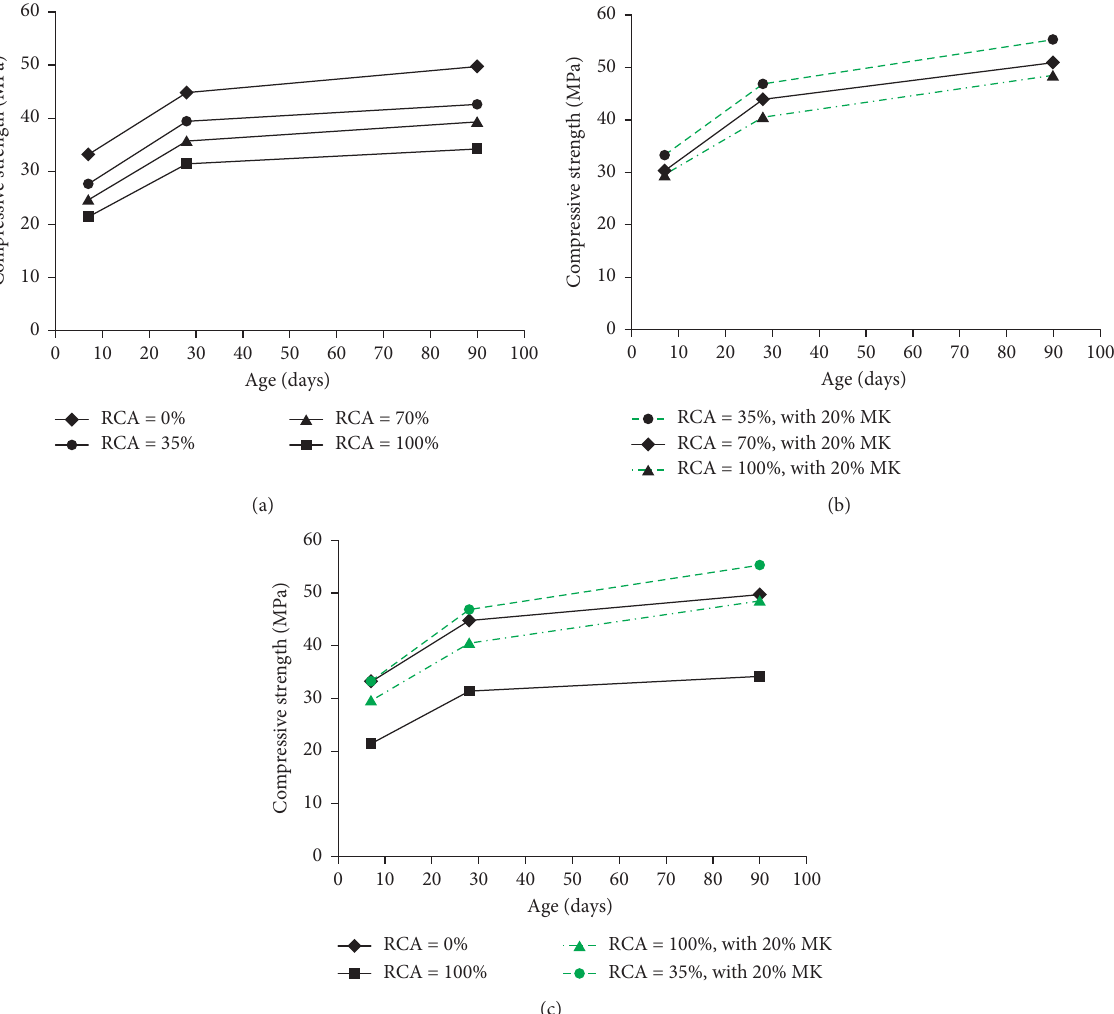
Figure 12: Strength development over time. (a) Mixes without MK. (b) Mixes with 20% of MK. (c) Comparing several mixes in (a) and Table 5: Results of splitting tensile strength (strength values and normalized strength). Group Mix designation Reference group or G0